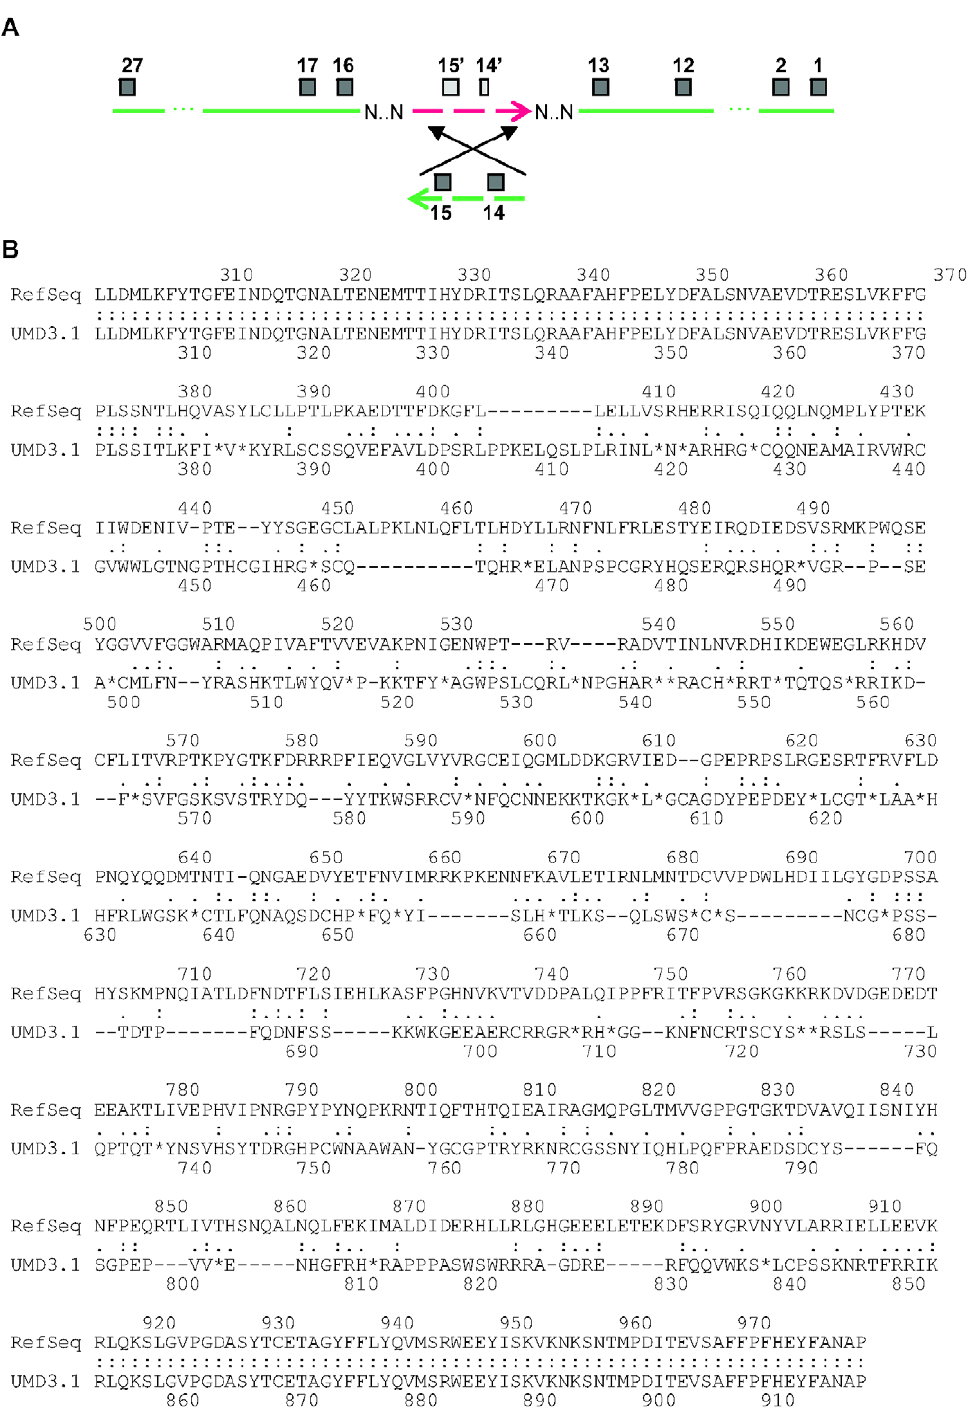
Figure 4. An assembly error at the AQR gene locus in UMD3 creates a significantly altered protein. (A) An incorrectly inverted contig (red) moves two exons (exons 14 and 15) to the wrong strand, causing the annotation software to miss them. Instead, it used low-quality alignments on the wrong strand, creating frameshifts in the predicted protein sequence that contained multiple premature stop codons. (B) Sequence alignment of the predicted AQR protein (conceptual translation) and its RefSeq